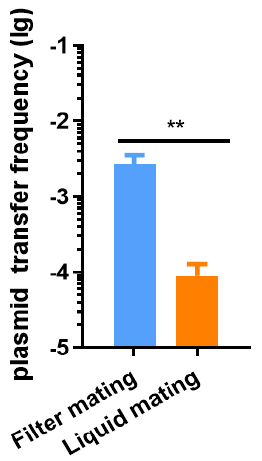
Figure 1. Different conjugation systems for quantitative measurement of plasmid transfer rate. The pHNSHP45 plasmid was transferred from K. pneumoniae A2312NM to K. pneumoniae D20-2